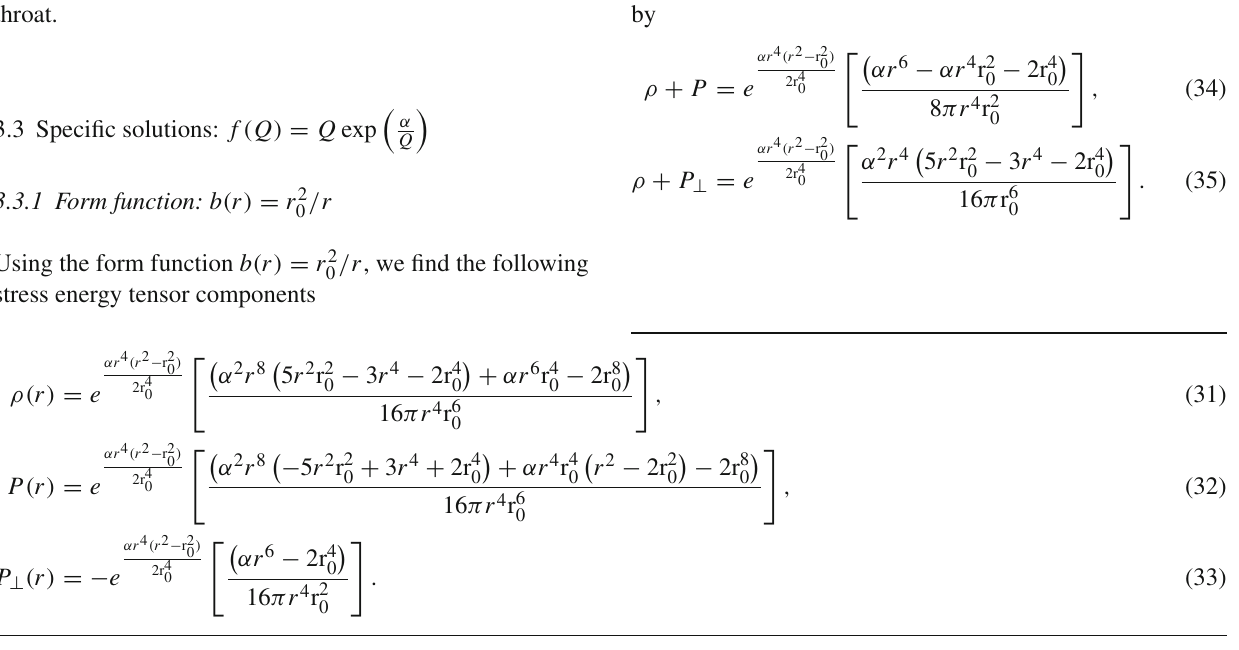
Fig. 2 The graphical behavior of NEC in terms of ρ , P and P ⊥ for the specific case of f ( Q ) = Q + α of the wormhole occurs at r 0 = 0 . 5. For this case the standard NEC is always violated at the throat of the wormhole, see Eqs. (29) and (30)